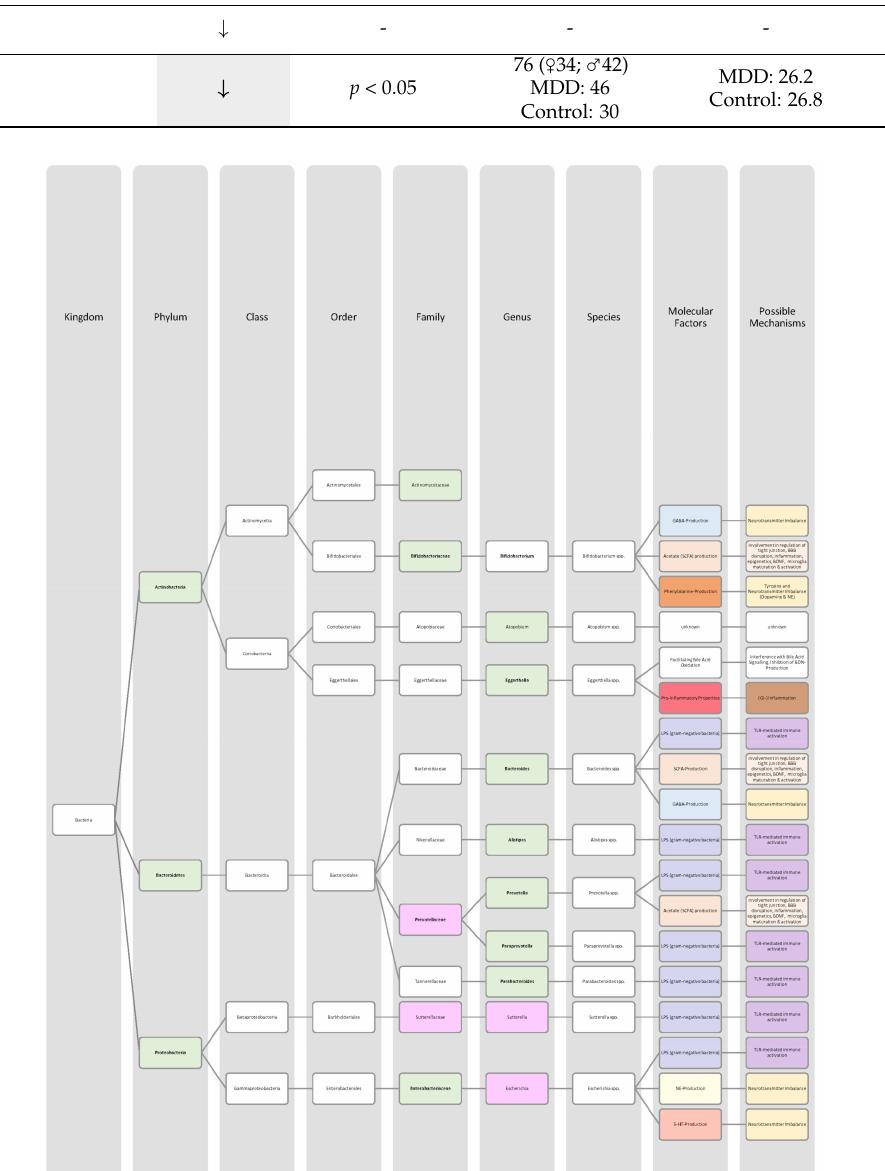
Figure 10. Part 1 of visual representation of the changes in microbiota composition in major depressive disorder (MDD) patients from Table 7. For an explanation, see the legend of Part 2 in Figure